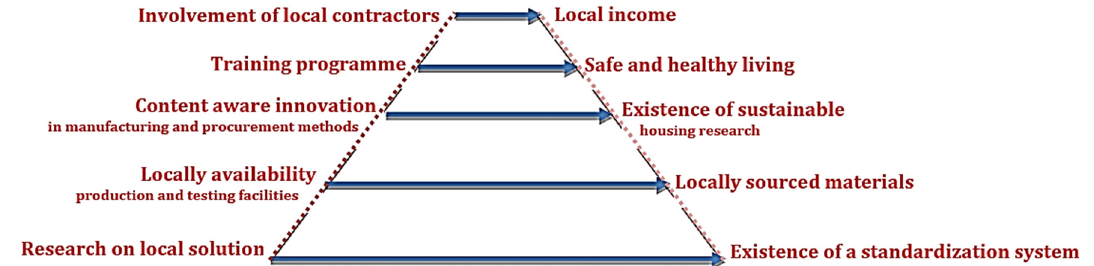
Figure 12. Links among the categories identified in this study and the sustainability indicators.